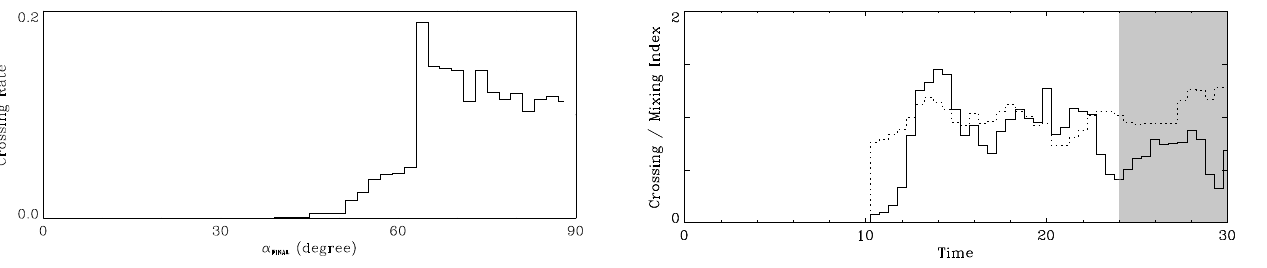
Fig. 10. (Solid line) crossing index and (dashed line) mixing index depending on normalized